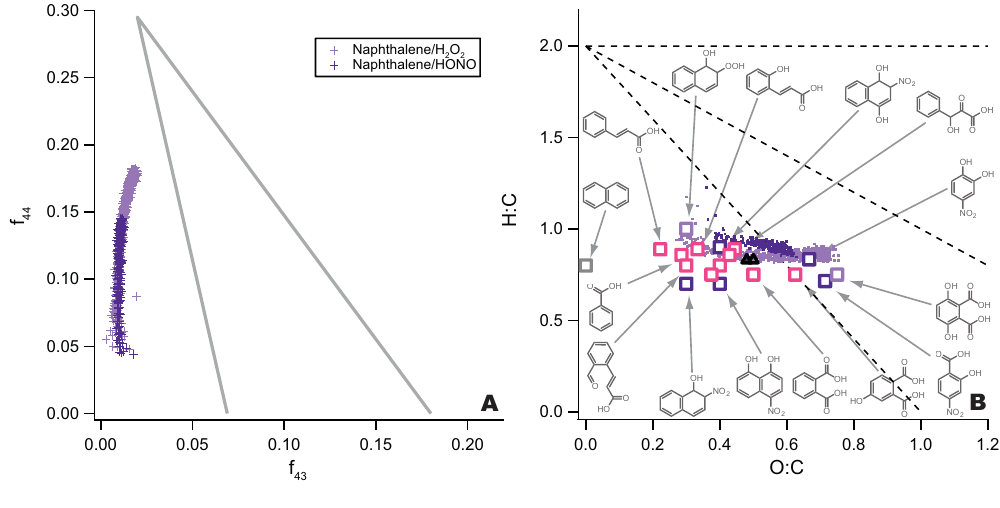
Fig. 5. (A) “Triangle” plot for SOA formed from photooxidation of naphthalene under low- and high-NO x conditions. Experiment progres- sion is from bottom to top. (B) Van Krevelen diagram for SOA formed from photooxidation of isoprene under low- and high-NO x conditions. Identified SOA products of high-, low-, and both NO x conditions are presented in dark purple, light purple, and pink boxes, respectively (Kautzman et al., 2009). The mass weighted average H/C and O/C at each NO x condition are represented by triangles of the same color. Kautzman et al. (2009) were able to chemically characterize 53–68% of the SOA